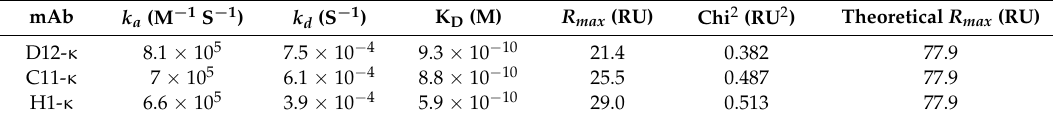
Table 2. Kinetic parameters for the interaction between the anti-CD117 IgG1 and the canine